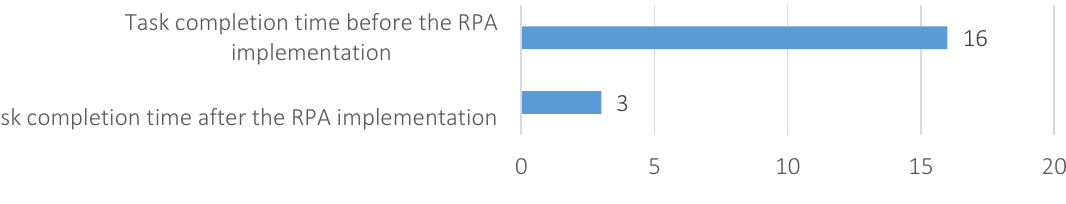
Figure 3. Maximum time of handling requests from competent authorities (in